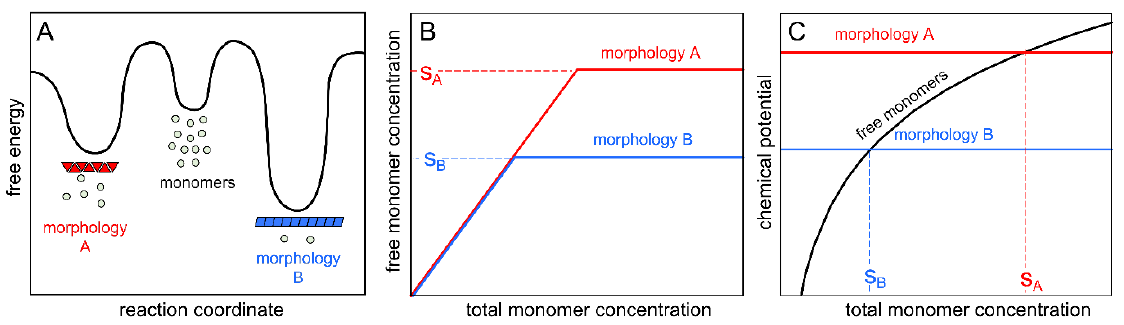
Figure 7. Schematic representation of the energy landscape and the solubility of morphologies A and B. ( A ) Simplified representation of the energy landscape for morphologies A and B, showing that morphology B (associated with a lower apparent solubility) is thermodynamically more stable (lower free energy). Primary nucleation is a very rare event. Once a seed of morphology A is formed in a sample, the replication of this morphology by elongation and secondary nucleation is energetically favored over primary nucleation, thus initially suppressing the emergence of the more stable morphology B. If a seed of morphology B is formed in a sample, the replication of this morphology by elongation and secondary nucleation is energetically favored over primary nucleation, thus suppressing the emergence of the less stable morphology A over time. Thus, the high effective energy barriers between morphologies A and B, and the pathway via monomers and de novo nucleation of fibrils of morphology B, may explain the kinetic stability of morphology A. ( B ) A simplified representation of the lower apparent solubility of the thermodynamically more stable morphology B (S B ) in comparison to that of morphology A (S A ). ( C ) Schematic illustration of the concentration-dependent chemical potential of free monomers (black curve) and the concentration-independent chemical potentials of monomers in fibrils of morphologies A (red line) and B (blue line). The crossover points correspond to the apparent solubility of each morphology.